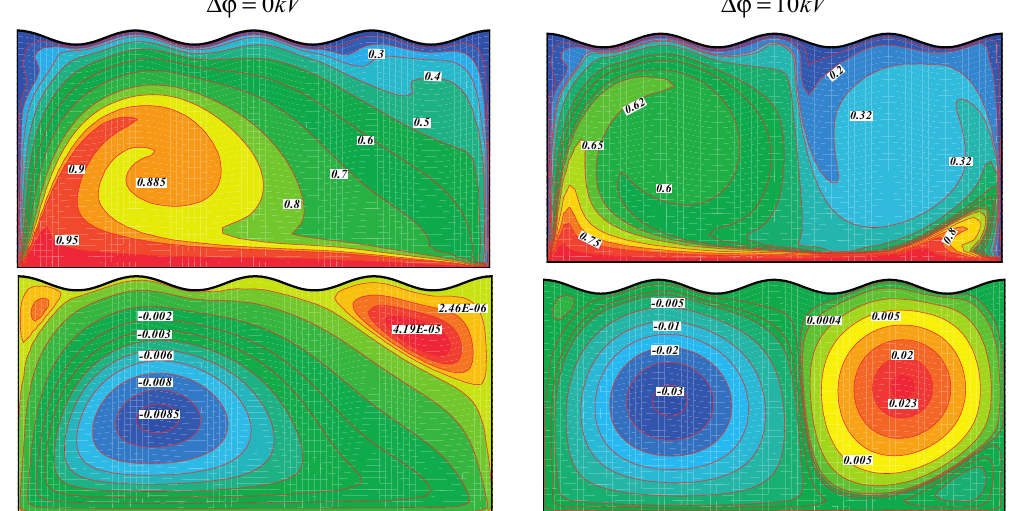
Figure 6. Effect of supplied voltage on streamlines and isotherm when 6000, 0.04 Re = φ = .